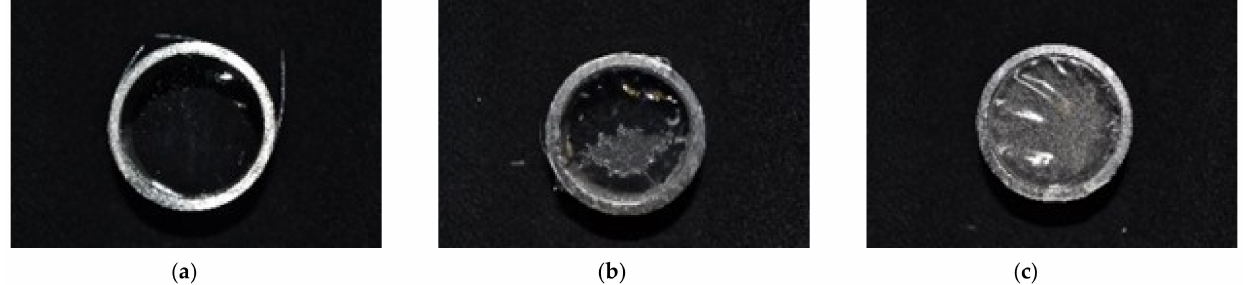
Figure 3. Examples of cast PLA films including different concentrations of Abies nordmanniana extract, resulting in varying degrees of inhomogeneity and turbidity. ( a ): F1 (0.2 mL extract per g PLA); ( b ): F4 (0.6 mL extract per g PLA); ( c ): F5 (1.0 mL extract per g